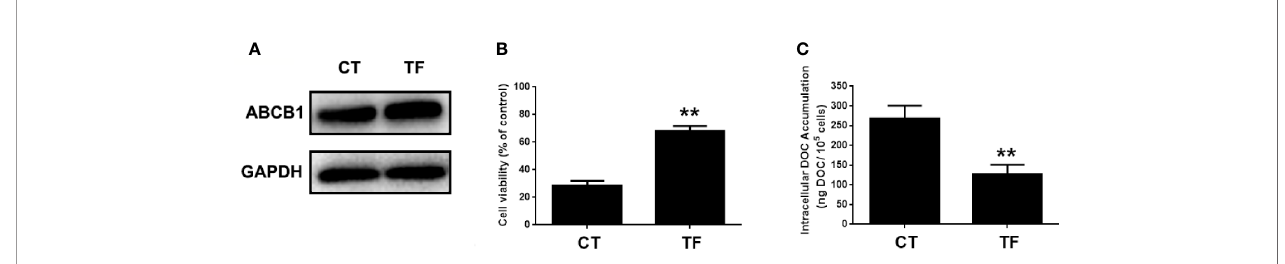
FIGURE 6 | The involvement of ABCB1 in the potentiated effect of maslinic acid (MA) on cellular docetaxel (DOC) accumulation in MDA-MB-231/DOC cells. MDA- MB-231/DOC cells with or without ABCB1 transfection were treated with DOC combined MA for 24 h. (A) The expression of ABCB1 in cells transfected with or without ABCB1 expression vector. (B) Cell viability was assessed by MTT assay. (C) Cellular DOC accumulation was evaluated by high performance liquid chromatography (HPLC) analysis. ** p < 0.01 vs. CT. All data were presented as means ± SD with three independent experiments, and triplicate repeats were included in each experiment. CT, control;